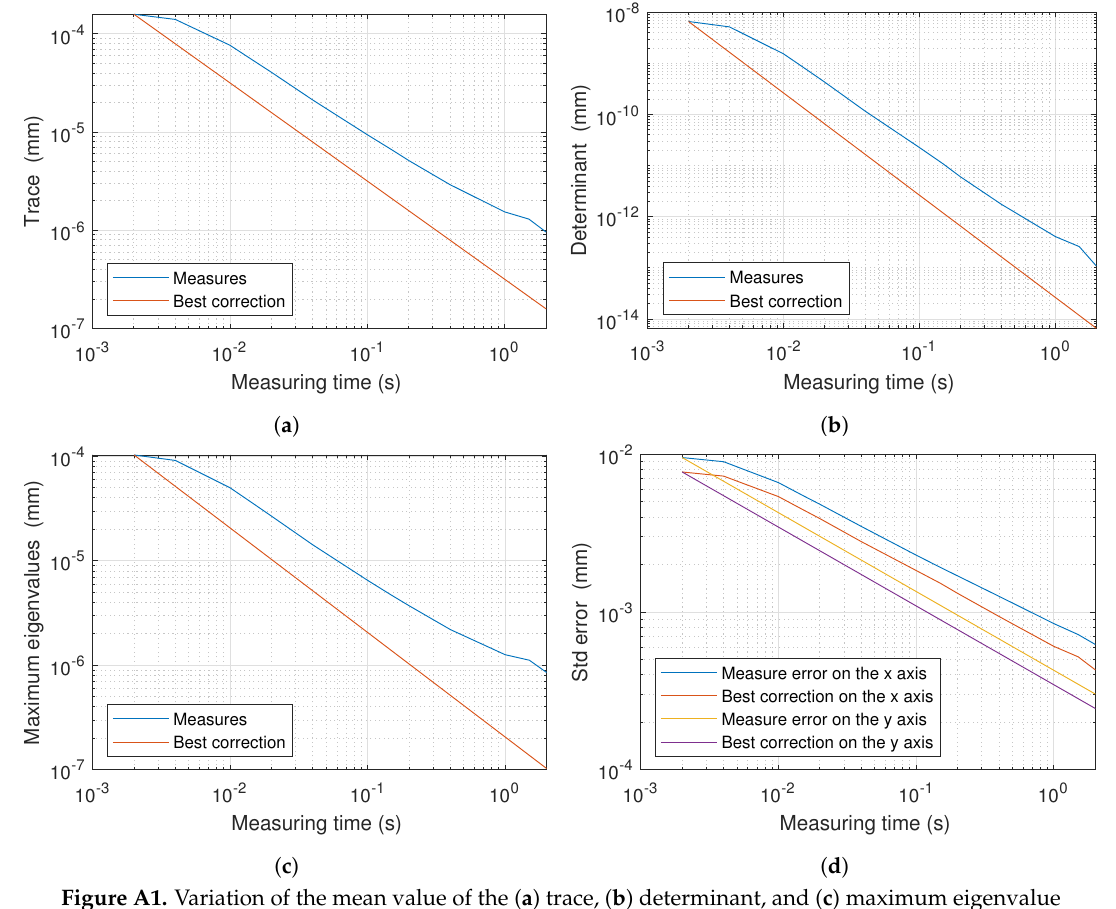
Figure A1. Variation of the mean value of the ( a ) trace, ( b ) determinant, and ( c ) maximum eigenvalue and ( d ) the standard deviation of the error on the x and y axes, as a function of the measurement time. Since the noise is not white Gaussian noise, the reduction in the values is less than